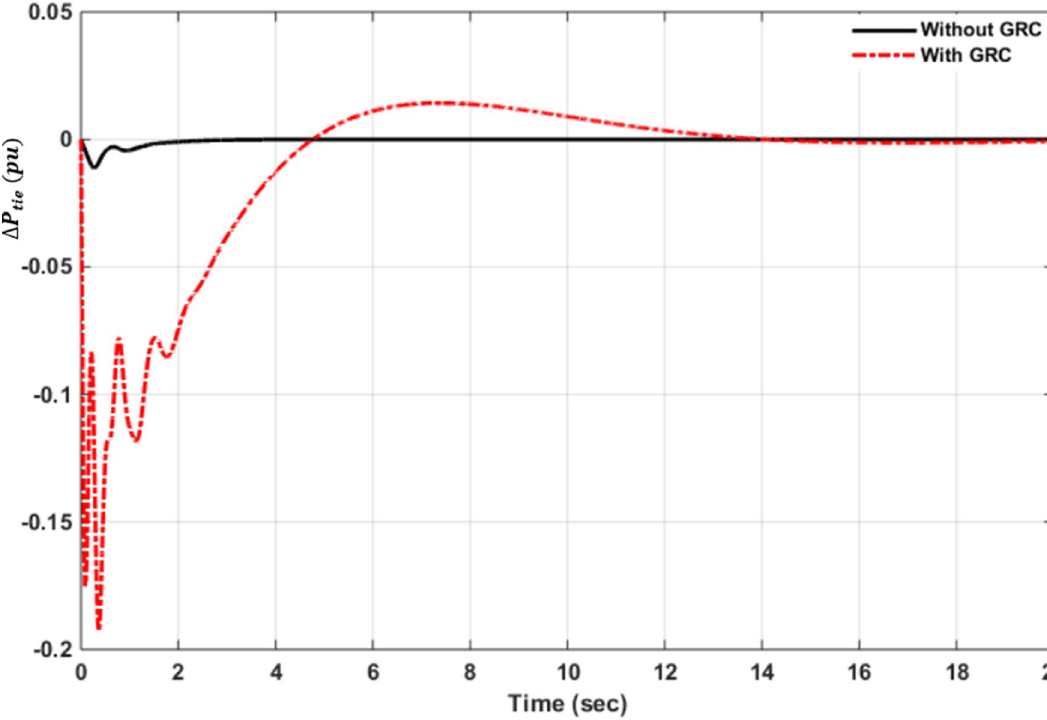
Figure 19. Tie-line deviation response to 1% SLP in multi-source power system with and without GRC. Thermal power system Controllers Settling time (s) Peak overshoot Optimal output